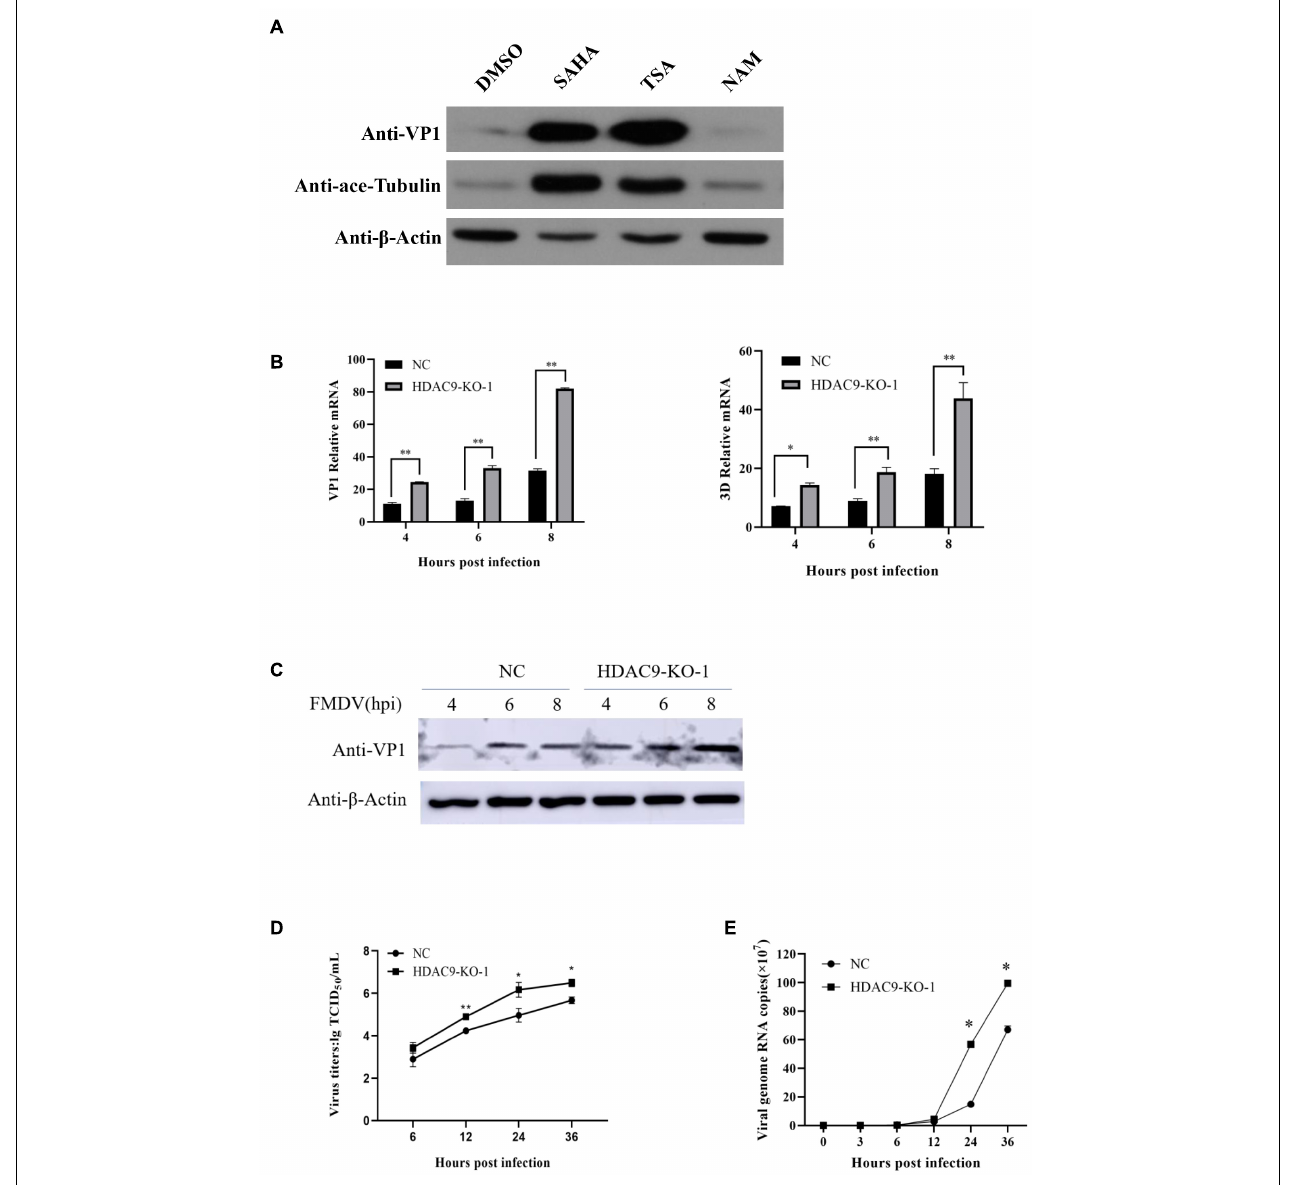
FIGURE 4 | HDAC9 knockout enhances FMDV replication. (A) BHK-21 cells were seeded in 60-mm dishes to reach an approximate 90% confluence and infected with FMDV at an MOI of 0.1. Cells were incubated for 1 h and treated with HDAC inhibitors (TSA, SAHA, and NAM), respectively. Samples were collected at 6 hpi. VP1 protein and ace-tubulin were determined by Western blot with indicated antibodies. (B) HDAC9 knockout cells (HDAC9-KO-1) and NC were infected with equal amounts of FMDV at an MOI of 0.1 for 4, 6, and 8 h. qRT-PCR was performed to examine the expression of FMDV VP1 and 3D relative mRNA. (C) The cells were infected with equal amounts of FMDV at the same time as in (B) . The expression of FMDV VP1 protein was determined by Western blot, and β -Actin was used as an internal reference. (D) FMDV titers were determined by the TCID 50 method after cells were infected with FMDV at an MOI of 0.001. (E) NC and HDAC9-KO cells were separately seeded in 24-well plates (5 × 10 5 cells/well), and the cells were infected with virus at an MOI of 0.001. Cells and supernatants were collected 0, 3, 6, 12, 24, and 36 hpi, and the expression of viral RNA was determined using qRT-PCR. All experiments were repeated three times, with similar results. Statistical significance was analyzed by Student’s t -test: * p < 0.05, ** p < 0.01.